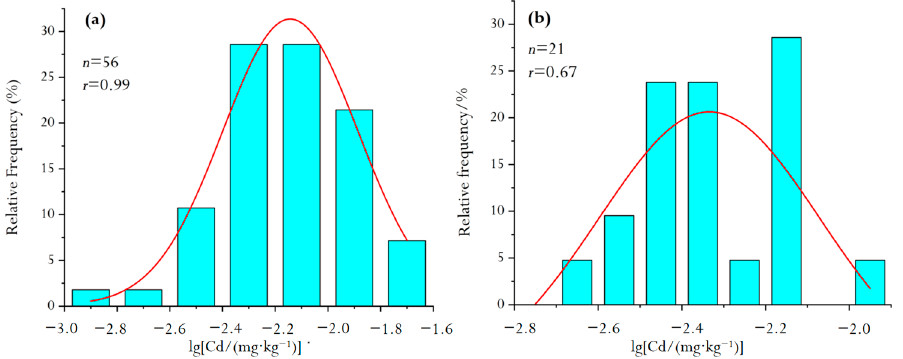
Figure 3. Frequency distribution histogram of Cd concentration in two soil parent materials. (( a ), RdcPm; ( b ), CPm). The total number of soil samples of carbonate soil parent material (CPm) was